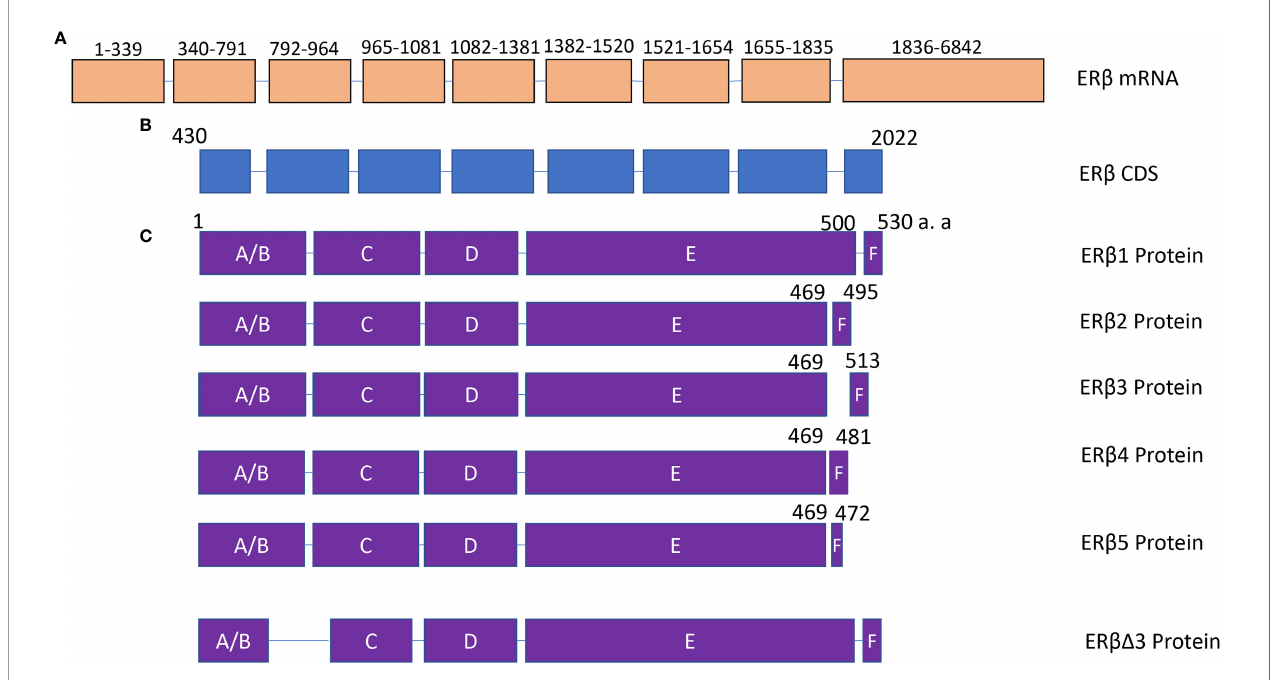
FIGURE 2 | The structure of ER b isoforms. (A) ER b mRNA contains 9 exons. NCBI reference sequence: NM_001437.3, transcript variant a. (B) ER b coding region. (C) The protein structure of ER b 1, ER b 2, ER b 3, ER b 4, ER b 5 and ER bD 3. The difference among ER b 1, ER b 2, ER b 3, ER b 4, and ER b 5 is mainly located in the C- terminal domain. DBD, DNA binding